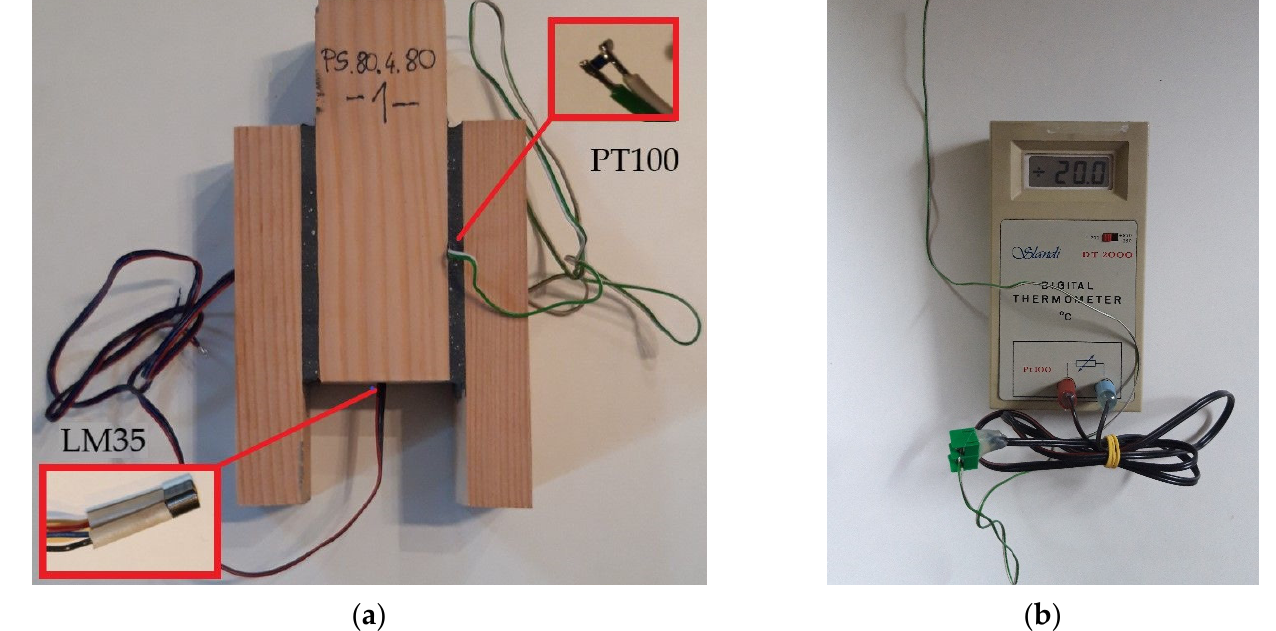
Figure 3. Temperature verification in a double lap joint: ( a ) specimen with sensors prepared for testing at 80 °C; ( b ) measuring instrument for temperature control in the adhesive joint.